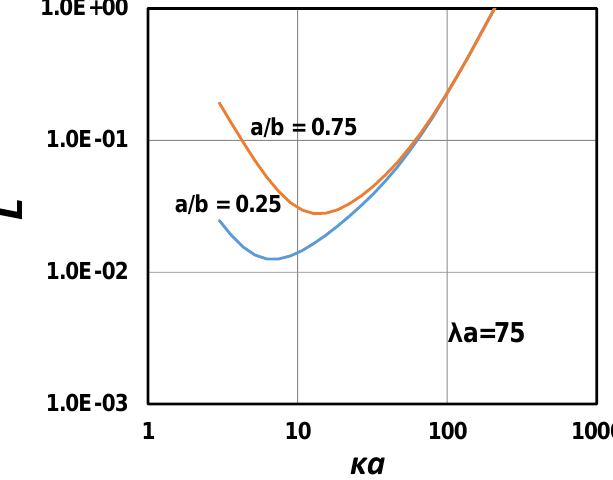
Figure 24. Plots of L versus κ a for two different values of a / b